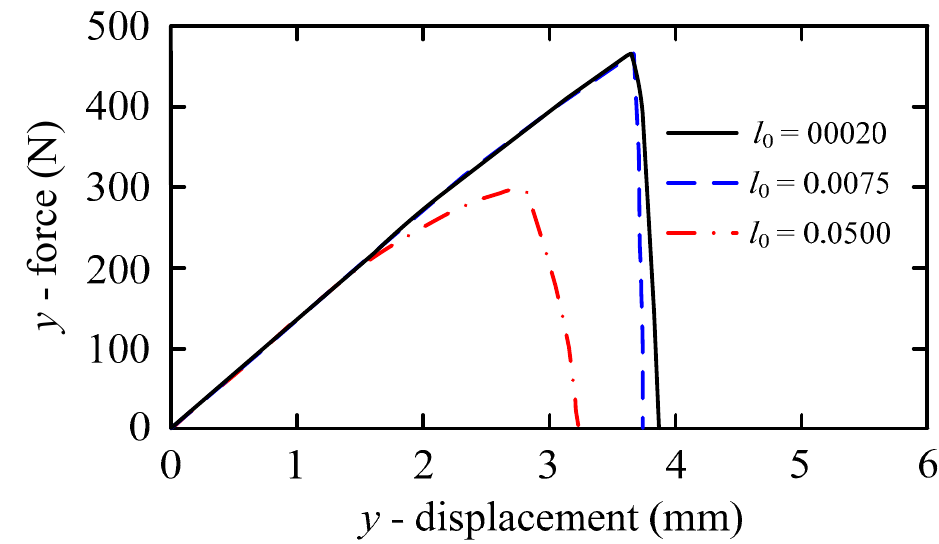
Figure 9. Load-displacement curves under different l 0 ( C 0 = 0.5 wt ppm).